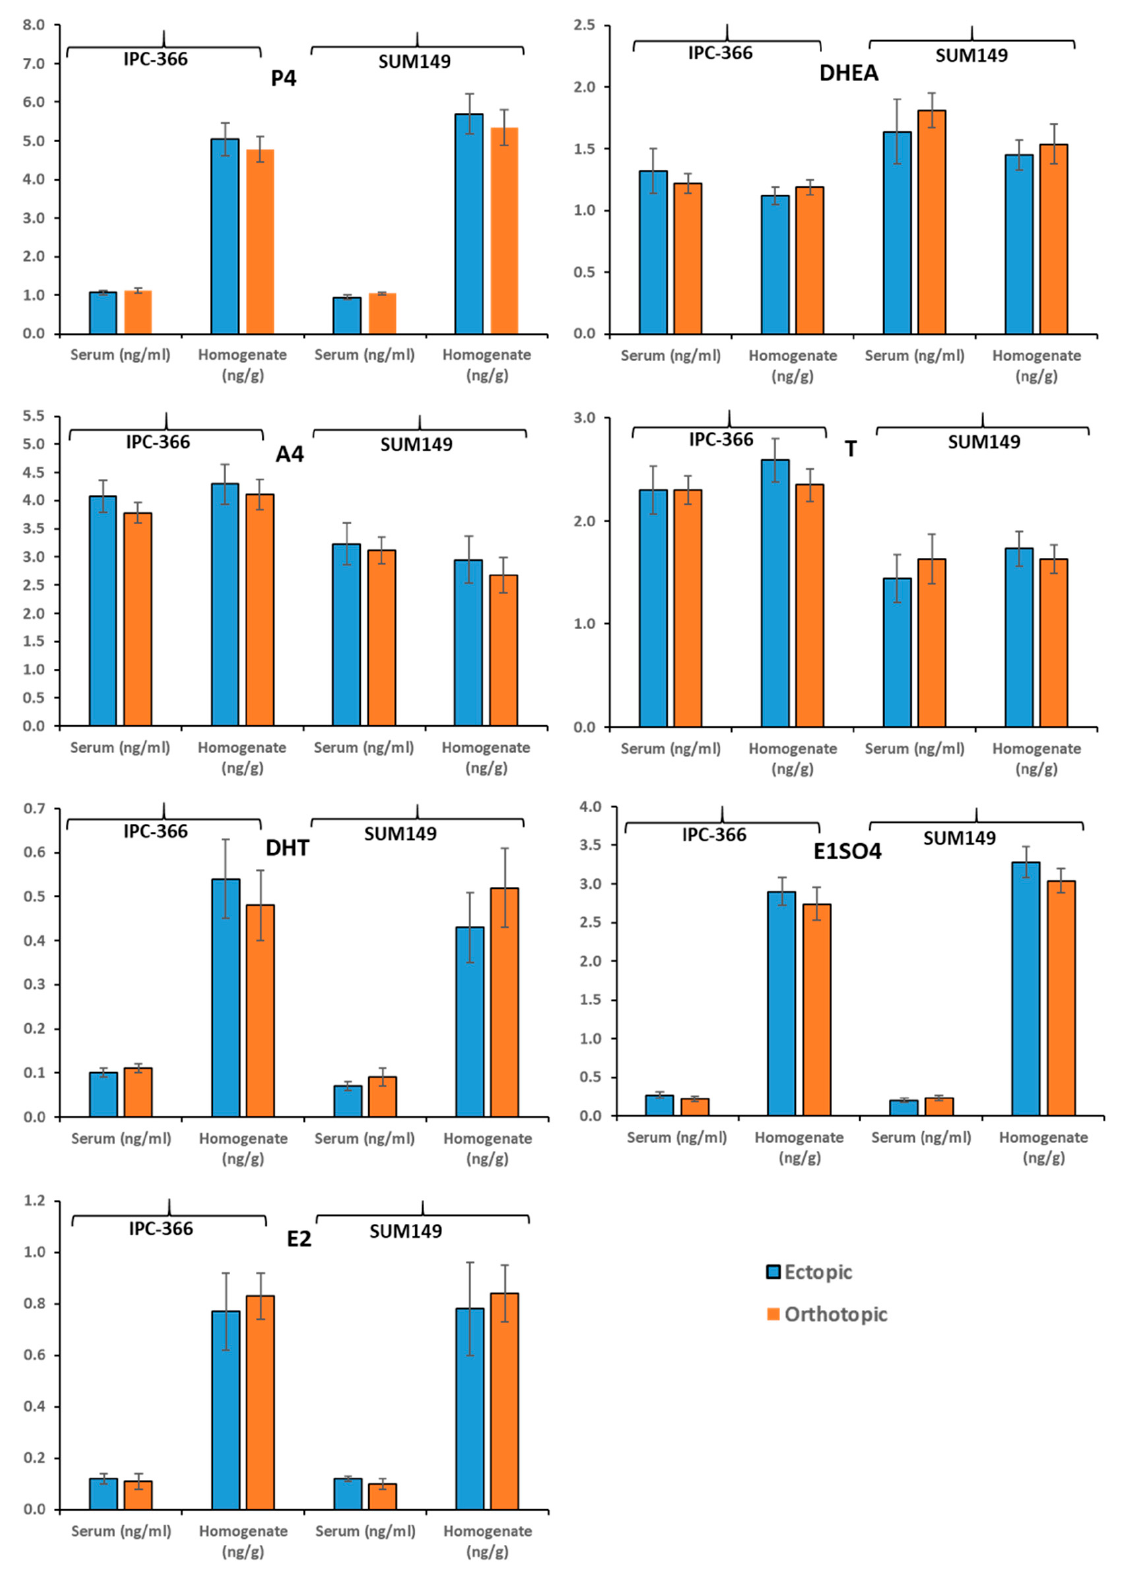
Figure 3. Steroid hormone secretion studied (P4, DHEA, A4, T, DHT, E1SO4, and E2), on ectopic (subcutaneous) and orthotopic (mammary fat pad) models of IPC-366 and SUM149 xenografts.